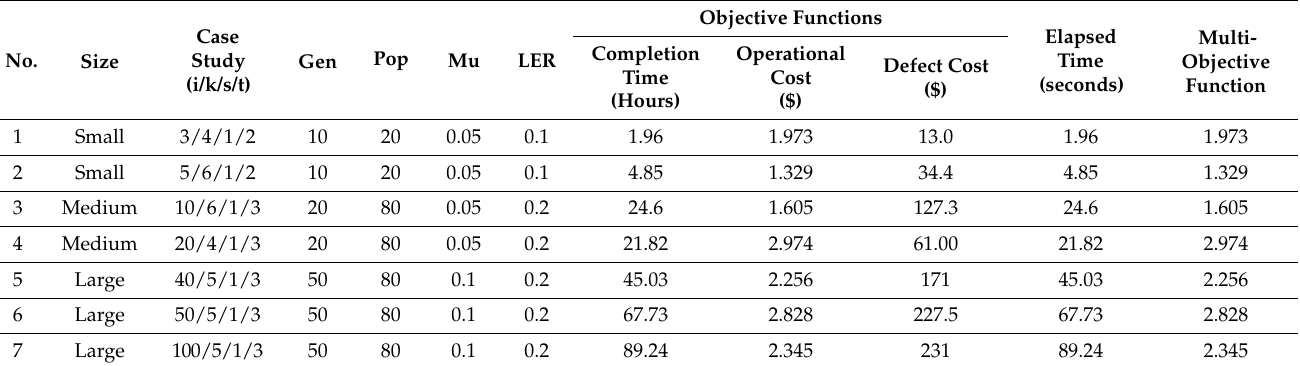
Table 10. Results of solving the case studies using NSGA-II.